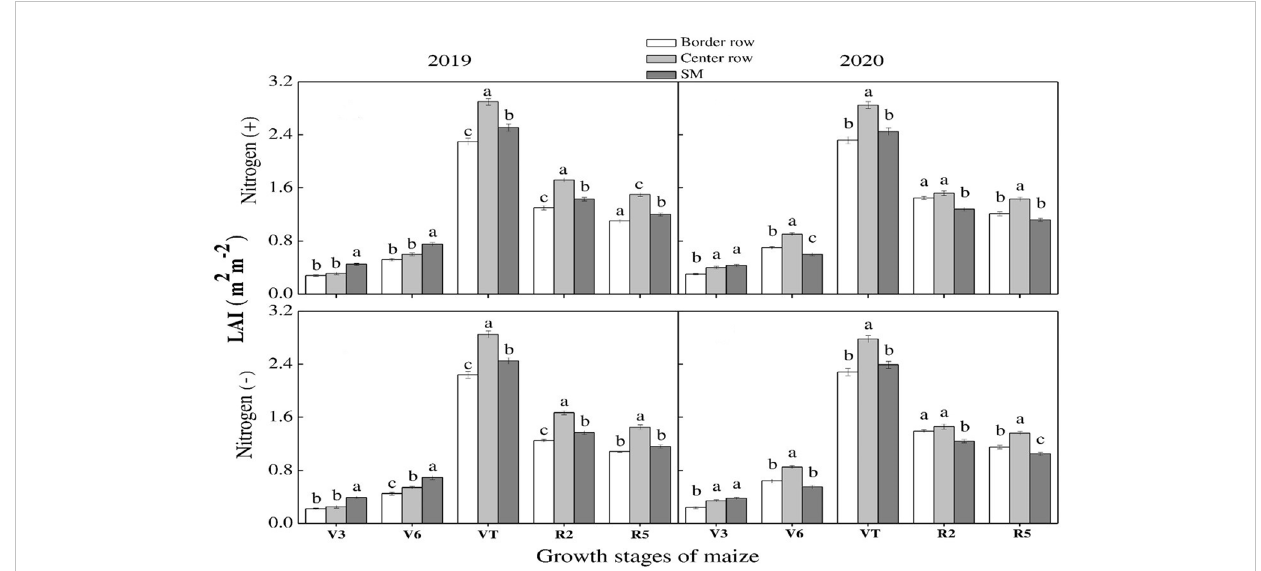
FIGURE 5 Leaf area index (LAI) of the border-, center- and sole maize (SM) crop at various growth stages under with- and without N application. Different letters on the top of each bar indicate signi fi cant differences among the various crop growth stages, as calculated by Tukey ’ s HSD test at P ≤ 0.05.